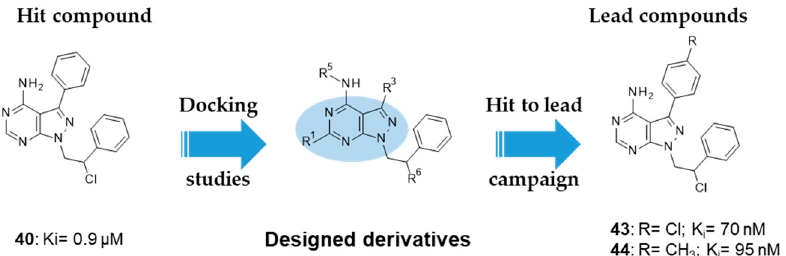
Figure 8. Schematic representation of the development of lead FYN inhibitors 43 and 44 starting from hit compound 40 (left). Chemical structures of FYN inhibitors 41 and 42 employed in the docking studies during a hit-to-lead optimization campaign [130].